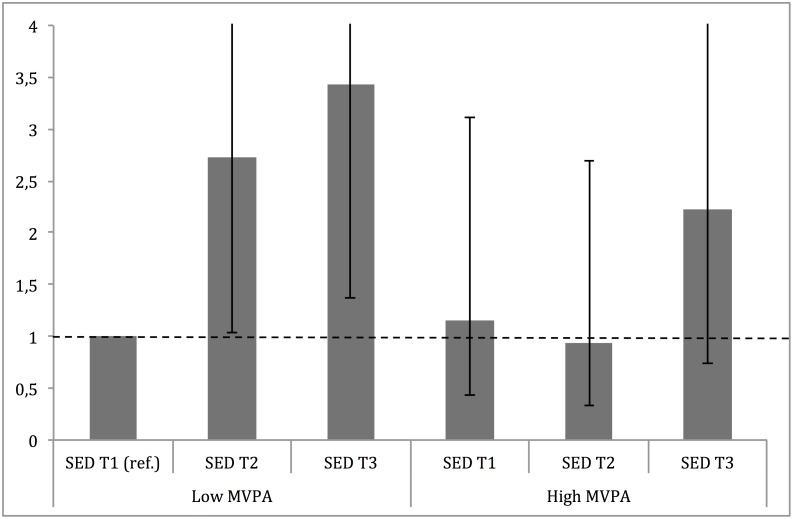
Stratified analysis across SED tertiles in high (above median) and low (below median) MVPA.ORs are adjusted for gender, age (yrs.), education level (university degree vs. not), energy intake (kcal·d-1, in quartiles), smoking habits (regular vs. not), psychosocial stress (self-reported into four levels) and fitness (in tertiles).